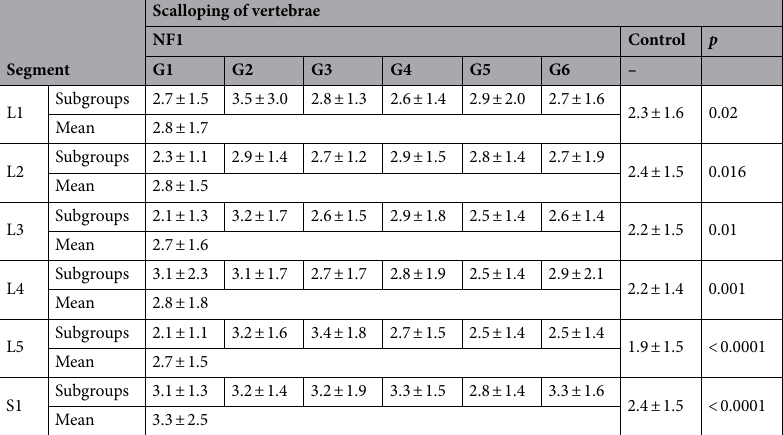
without neuroforaminal tumors (all segments p < 0.0001). Measurement of scalloping revealed a greater differ- ence between midsagittal diameters and superior / inferior sagittal diameters in vertebral bodies of NF1 patients (2.7–3.3 mm) compared with control patients (1.9–2.4 mm) (Table 3). Spinal abnormalities and association with NF1. Significant associations between six parameters of spinal abnormalities and NF1 were identified. Due to the application of Bonferroni adjustment for multiple testing, adjusted p-values and 99.5% confidence intervals are reported. These six items were: scoliosis (OR 16.9; 99.5% CI 7.1–40.3; p < 0.0001), dural ectasia (Ahn) (OR 2.7; 99.5% CI 1.6–4.5; p < 0.0001), dural ectasia (Oost) (OR 3.6; 99.5% CI 2–6.6), neuroforaminal tumors (OR 345.3; 99.5% CI 0–6.3; p = 0.0004), spinal tumors (3.7; OR 1.3–10.4; p = 0.0036), and scalloping (Fat) (OR 4.4; 99.5% CI 1.6–10.8; p < 0.0001). Other associations between NF1 and spinal abnormalities did not reach significance ( p > 0.05) (Table 1). Odds ratios of other investigated spinal abnormalities in NF1 patients are given in Table 1. Spinal abnormalities and genetic subgroups. Overall, the investigated spinal abnormalities displayed an almost evenly distribution between the genetic subgroups. No association between spinal abnormalities and a specific genetic subgroup was identified (Figs. 2, 3). The most common deformity in all genetic subgroups was dural ectasia (Oost) . Other abnormalities with high prevalence in the respective genetic subgroups were: group 1: dural ectasia (Ahn) (61.1% ); group 2: dural ectasia (Ahn) (68.8%); group 3: scoliosis (50%); group 4: scoliosis (50%); group 5: scoliosis and dural ectasia (Ahn) (both 41.4%); group 6: scoliosis (52.5%). Associations of the genetic pro- file with investigated items did reveal large p-values of calculated odds ratios (Figs. 2, 3). More detailed informa- tion on the association of spinal abnormalities and genetic subgroups and prevalences of all spinal abnormalities within the different genetic subgroups are provided in Supplemental Table S1. Co‑appearance of spinal abnormalities. The analysis to investigate if scoliosis, scalloping, dural ectasia, meningoceles and neuroforaminal tumors influence each other’s appearance showed relevant effects. Patients who suffered from scalloping of vertebral bodies had relevantly increased odds for development of scoliosis (OR 3.01; p = 0.002). Patients who suffered from scoliosis ( p = 0.002; OR 3.13), meningoceles (OR 7.63; p = 0.001) or neuroforaminal tumors (OR 2.96; p = 0.002) had increased odds for development of scalloping of vertebral bod- ies. Suffering from scalloping of vertebral bodies relevantly increased odds for meningoceles (OR 7.7; p = 0.001) and for neuroforaminal tumors (OR 2.89; p = 0.002). The presence of dural ectasia (Ahn) also increased odds to suf- fer from neuroforaminal tumors (OR 1.93; p = 0.011). Neuroforaminal tumors relevantly increased odds to suffer from dural ectasia (Ahn) (OR 1.93; p = 0.011), whereas dural ectasia (Oost) did not (OR 1.16; p = 0.69). More detailed results on co-appearance of these spinal abnormalities are provided in Supplemental Figure S1. Clinical symptoms in NF1 patients. The most common clinical symptom within the NF1 group was pain of the thoracic spine (29/275; 10.5%). Other common clinical symptoms were impairment or loss of motor function in 27/275 (9.8%) patients and pain of the lumbar spine (25/275; 9.1%). Further details on clinical symp- toms overall and within the genetic subgroups are given in Table 4. Analysis for clinical symptoms and their association with NF1 showed that age influenced back pain (OR 1.03; p = 0.006) (Fig. 4 a) and that male sex influenced loss of motor function (OR 3.06; p = 0.023) (Fig. 4 b). None